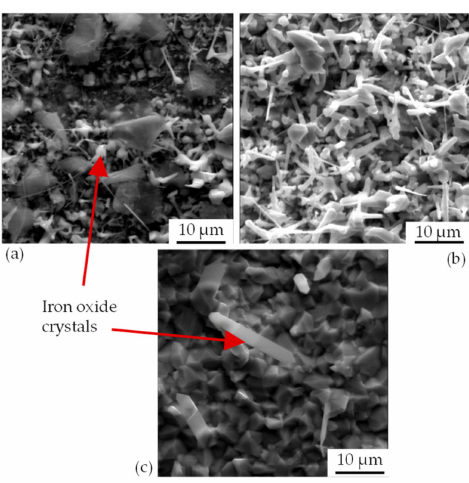
Figure 6. SEM plan-view micrographs of particle-loaded sample Alloy 800H at 750 ◦ C and 6 MPa helium, annealed thermally: ( a ) 10, ( b ) 100, and ( c ) 1000